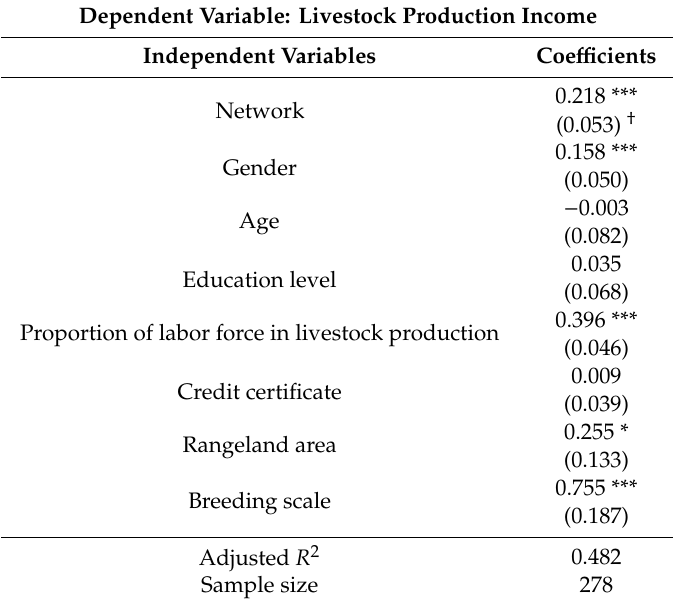
Table8. Estimationresultsforthee ff